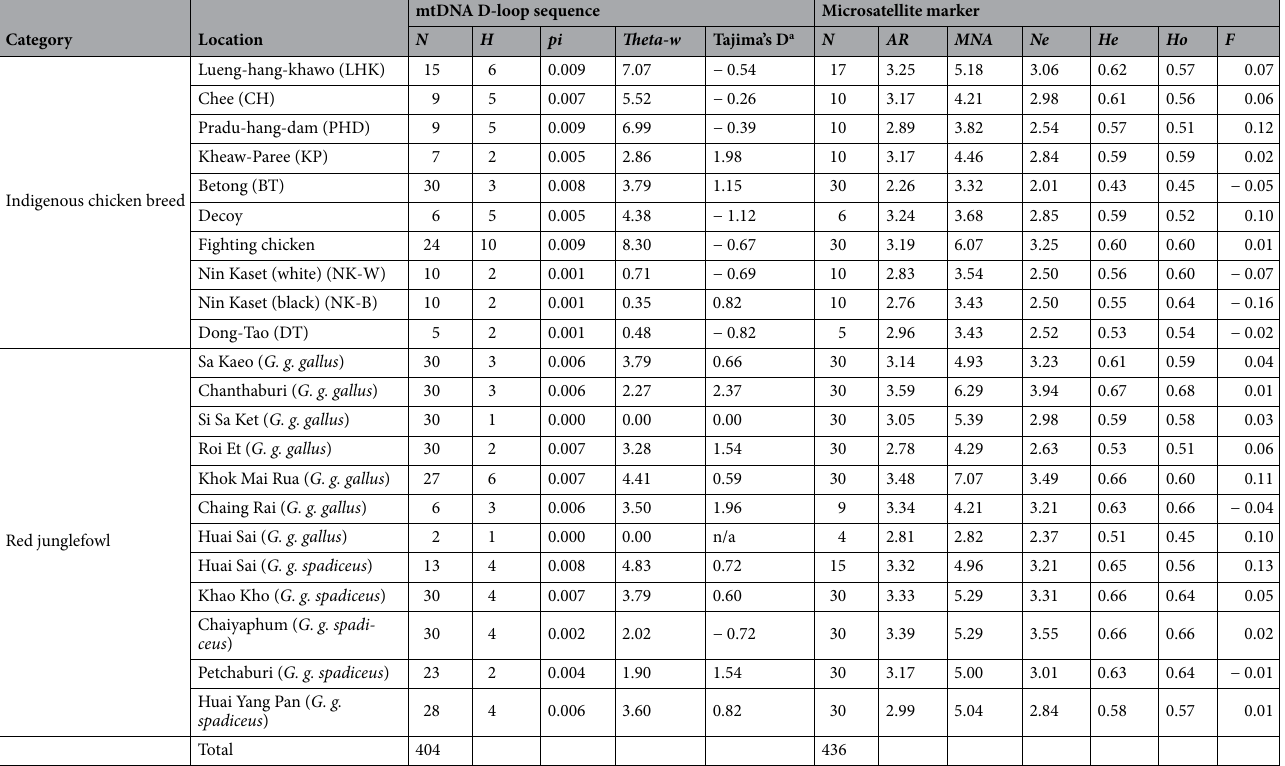
Table 3. Genetic diversity of indigenous chicken breeds and red junglefowl populations estimated using of mtDNA D-loop sequences and 28 microsatellite markers. N : Number of individuals examined. H : Number of observed haplotypes. pi : Nucleotide diversity. Theta-w : Watterson estimator ( Theta-w per sequence in Dnasp). AR : Allelic richness, MNA : Mean number of allesles per locus, Ne : Number of effective alleles frequencies = 1/ (Sum pi 2 ). He : Expected heterozygosity. Ho : Observed heterozygosity. F : Fixation index = ( He − Ho )/ He. a No statistical significance was detected for all of 22